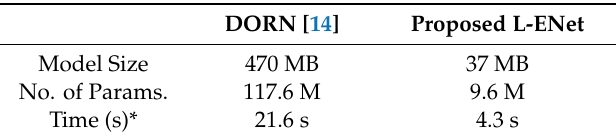
Table 4. Comparison of the model size, number of parameters and processing times for the proposed method and a DORN approach using the KITTI